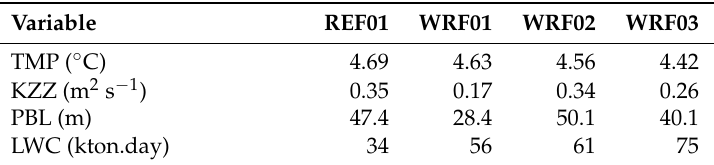
Table 10. Average temperature (TMP), PBL height, the cumulated liquid water content (LWC) (as computed by Equation (1)) and the vertical eddy diffusion coefficient (KZZ) on 12 December for the simulations REF01, WRF01, WRF02 and WRF03 over the ARV0011 domain at 1 ⁄ 90 ◦ resolution. The averaging process in 3D or 2D (depending on the variable) is masked for grid cells where PM10 > 10 µ g m − 3 in REF01 simulation to target the most polluted area in the domain.